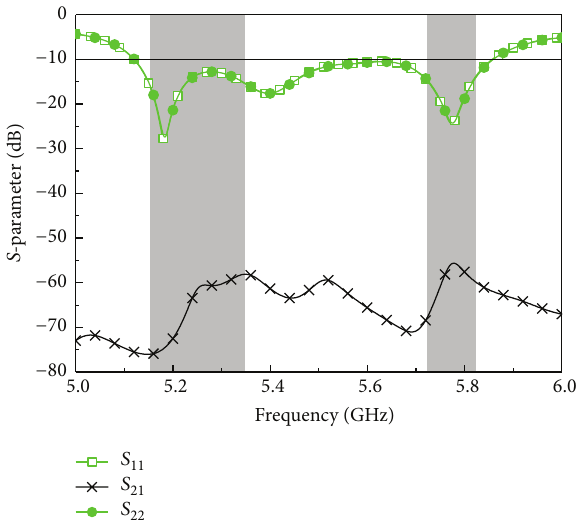
Figure 16: Simulated 𝑆 -parameters of the on-body to on-body communication